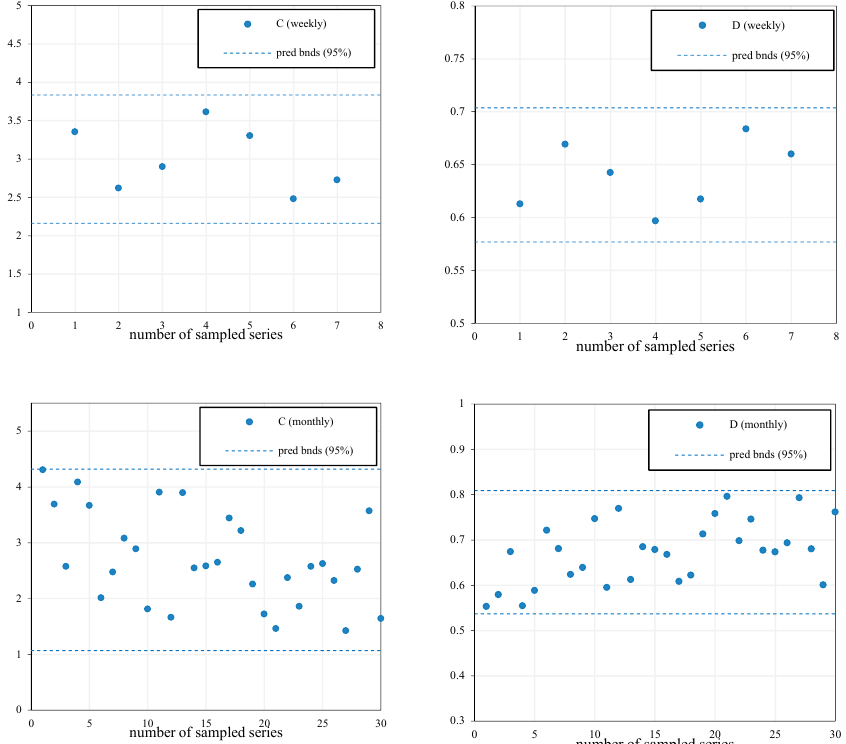
Figure 7. 95% prediction boundaries for the regression model parameters C and D in Equation (8) for the case of discontinuous measurements. The upper panel refers to a weekly monitoring program, and the lower panel refers to a monthly monitoring program.